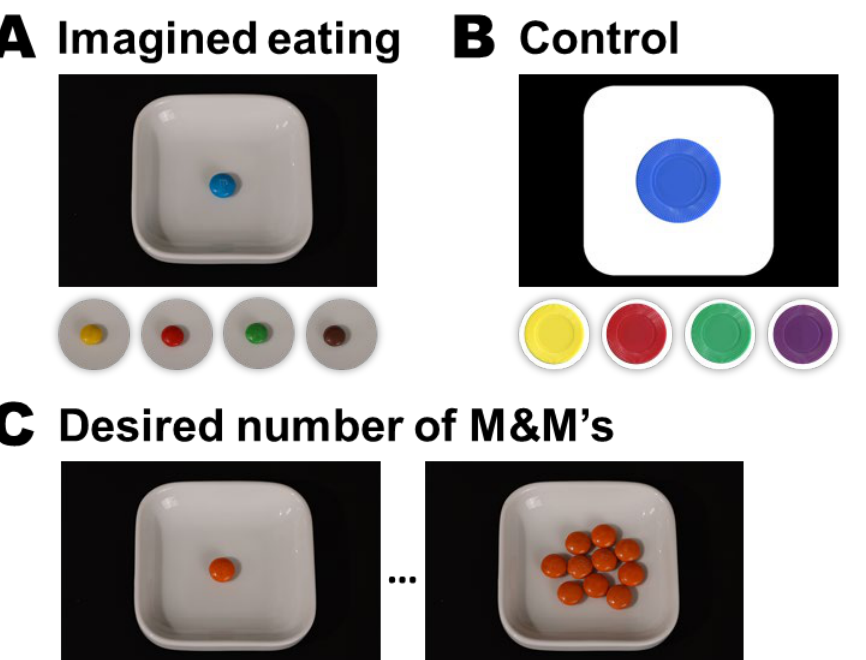
Figure 2. The visual stimuli used in the study. Panels A and B show the visual stimuli used during the experimental manipulation in the imagined eating ( A ) and control ( B ) groups. The actual eating group saw only a text instruction (see Figure 3); thus, it is not shown here. Panel C shows the first (1) and last (10) choice options when participants were asked to indicate the number of M&Ms they desired to eat at the moment, at the end of the study.